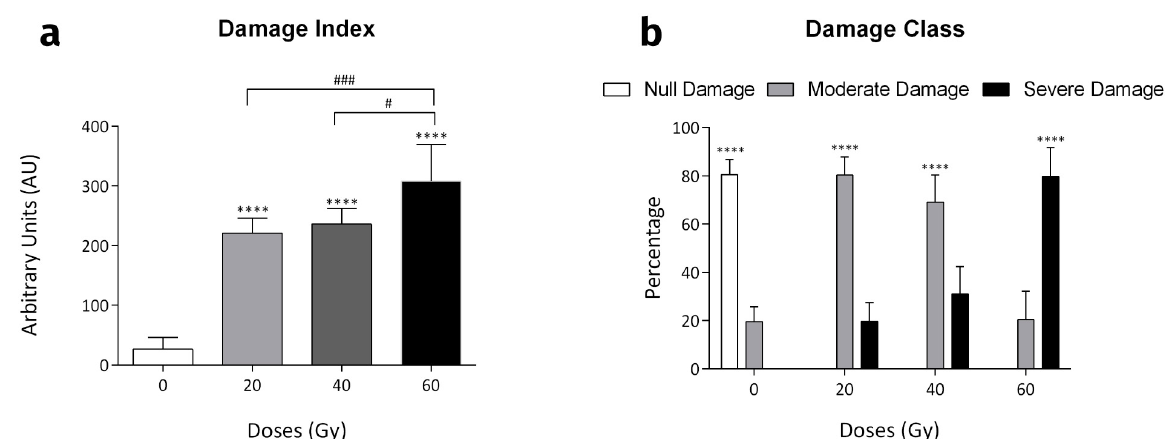
Figure 5. Genomic damage after total dose of SBRT. Radiation-induced genotoxic effect evaluated in the A549 cell line just after irradiation . a. Results were plotted as damage index vs Gy dose irradiation and expressed as mean ± SD. One-way ANOVA and post-hoc Tukey’s test, **** p < 0.0001 versus untreated control cells and ### p < 0.001 and # p < 0.1 versus cells treated with 20 and 40-Gy, respectively. b. Results were plotted as damage class vs Gy dose irradiation and expressed as mean ± SD. Two-way ANOVA and post-hoc Tukey’s test, **** p < 0.0001 versus the other class of damage at the same irradiation